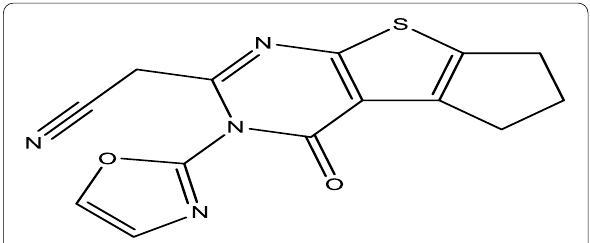
Figure5 Template compound (C10), 2-(3-(oxazol-2-yl)-4-oxo-4, 5, 6, 7-tetrahydro-3H-cyclopent [4, 5] thieno[2,3-d] pyrimidin-2-yl) acetonitrile for the designed